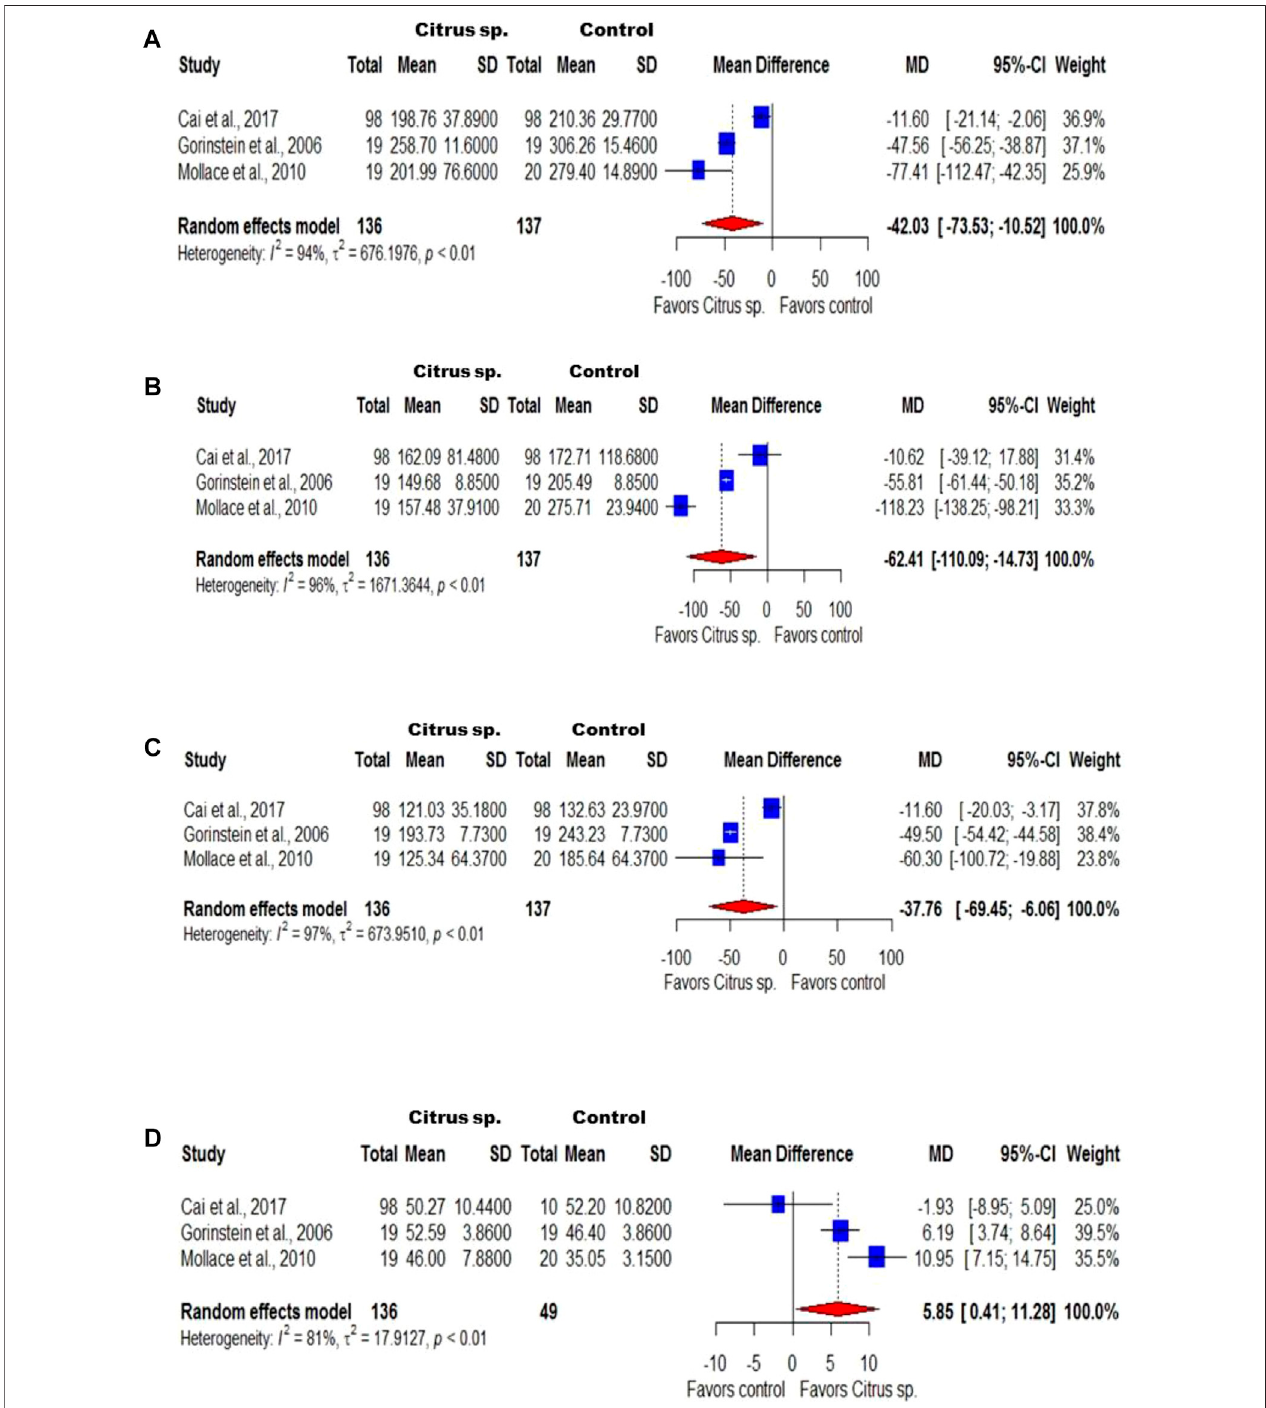
FIGURE 5 | Forest plot of the clinical studies that evaluated the effect of Citrus species on total cholesterol (A) , triglyceride (B) , LDL (C) , and HDL (D) levels. The numbers on the x -axis indicate the effect of the treatment and its favoring. SD: standard deviation of the differences. MD: difference between the means.